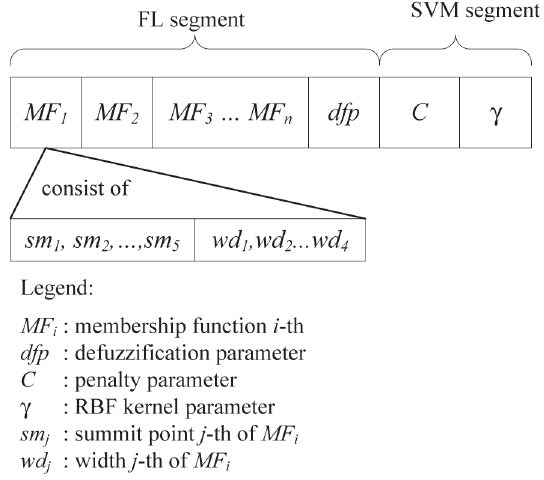
Fig. 5. EFSIM chromosome structure